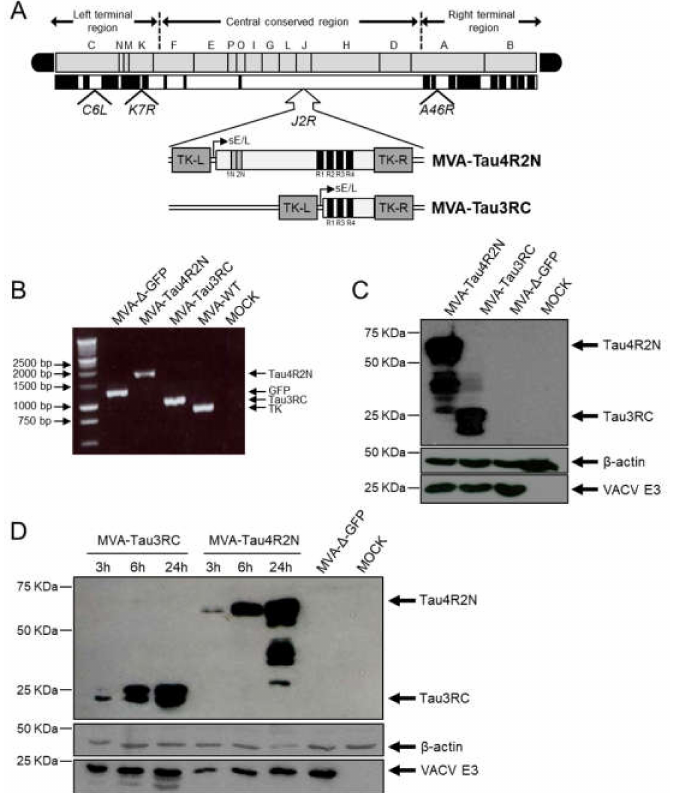
Figure 1. Generation and in vitro characterization of MVA-Tau4R2N and MVA-Tau3RC vaccine candidates. ( A ) Scheme of the MVA-Tau4R2N and MVA-Tau3RC genome map. The full-length human tau gene (isoform Tau4R2N, including 2 N-terminal inserts and 4 microtubule-binding repeats) and the Tau3RC fragment (including 3 microtubule-binding repeats) are driven by the VACV sE / L promoter and are inserted within the VACV TK viral locus ( J2R ). The deleted VACV C6L , K7R , and A46R genes are indicated. TK-L, TK left; TK-R, TK right. ( B ) PCR analysis of the VACV TK locus. Viral DNA was extracted from DF-1 cells mock infected or infected at 5 PFU / cell for 24 h with